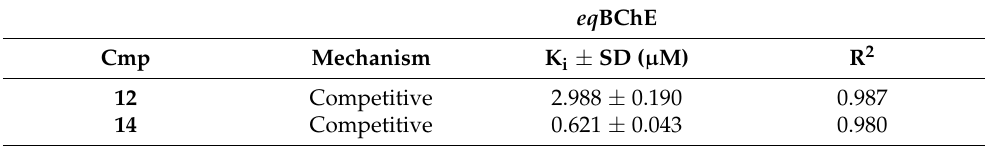
Table 3. Inhibition constants (K i ) and inhibition mechanism of compounds 12 and 14 on eq BChE.